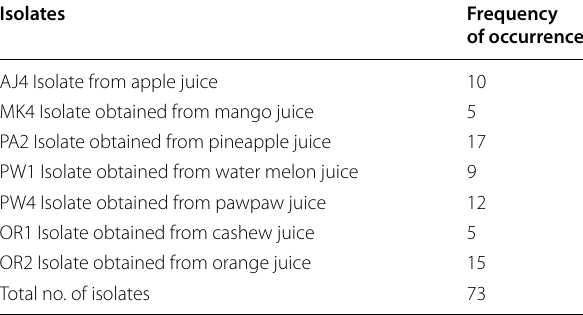
Table 1 Frequency of occurrence